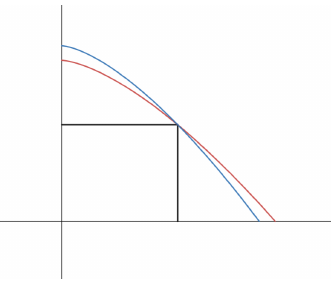
minimizes the area. Usually these two curves do not 3